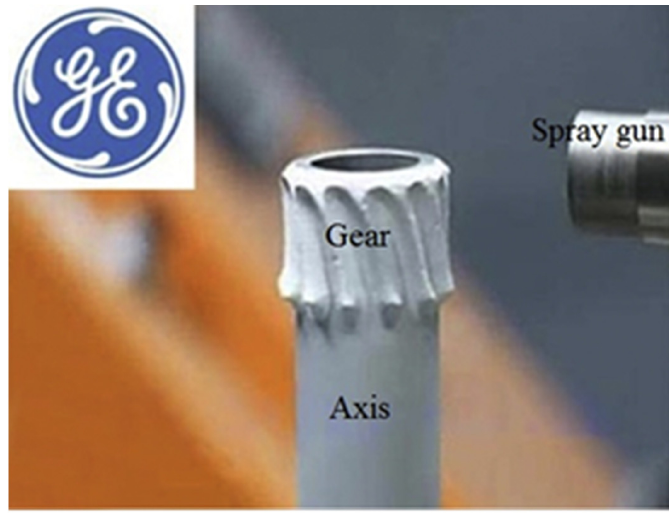
Figure 9. Cold-spray additive manufacturing gear [63].